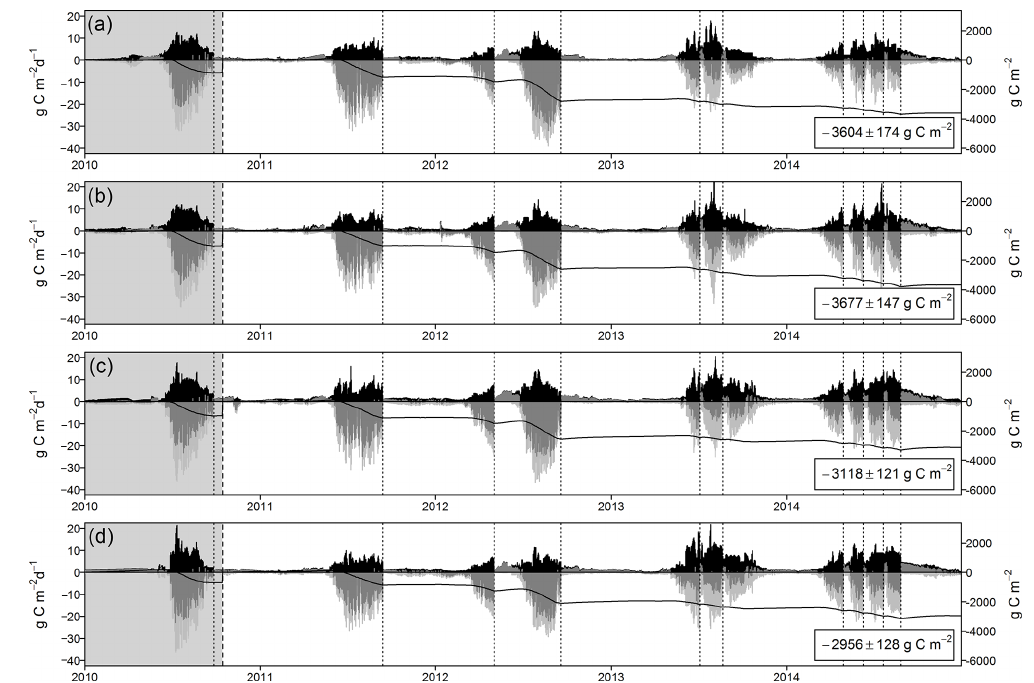
Figure 3. Time series of CO 2 exchange (a–d) for the four chambers of the AC system during the study period from 2010 to 2014. R eco (black), GPP (light gray) and NEE (dark gray) are shown as daily sums ( y axis). NEE cum is presented as a solid line, representing the sum of continuously accumulated daily NEE values (secondary y axis). The presented values display cumulative NEE following soil manipulation to the end of 2014. Note the different scales of the y axes. The gray shaded area represents the period prior to soil manipulation. The dashed vertical line indicates the soil manipulation. Dotted lines represent harvest